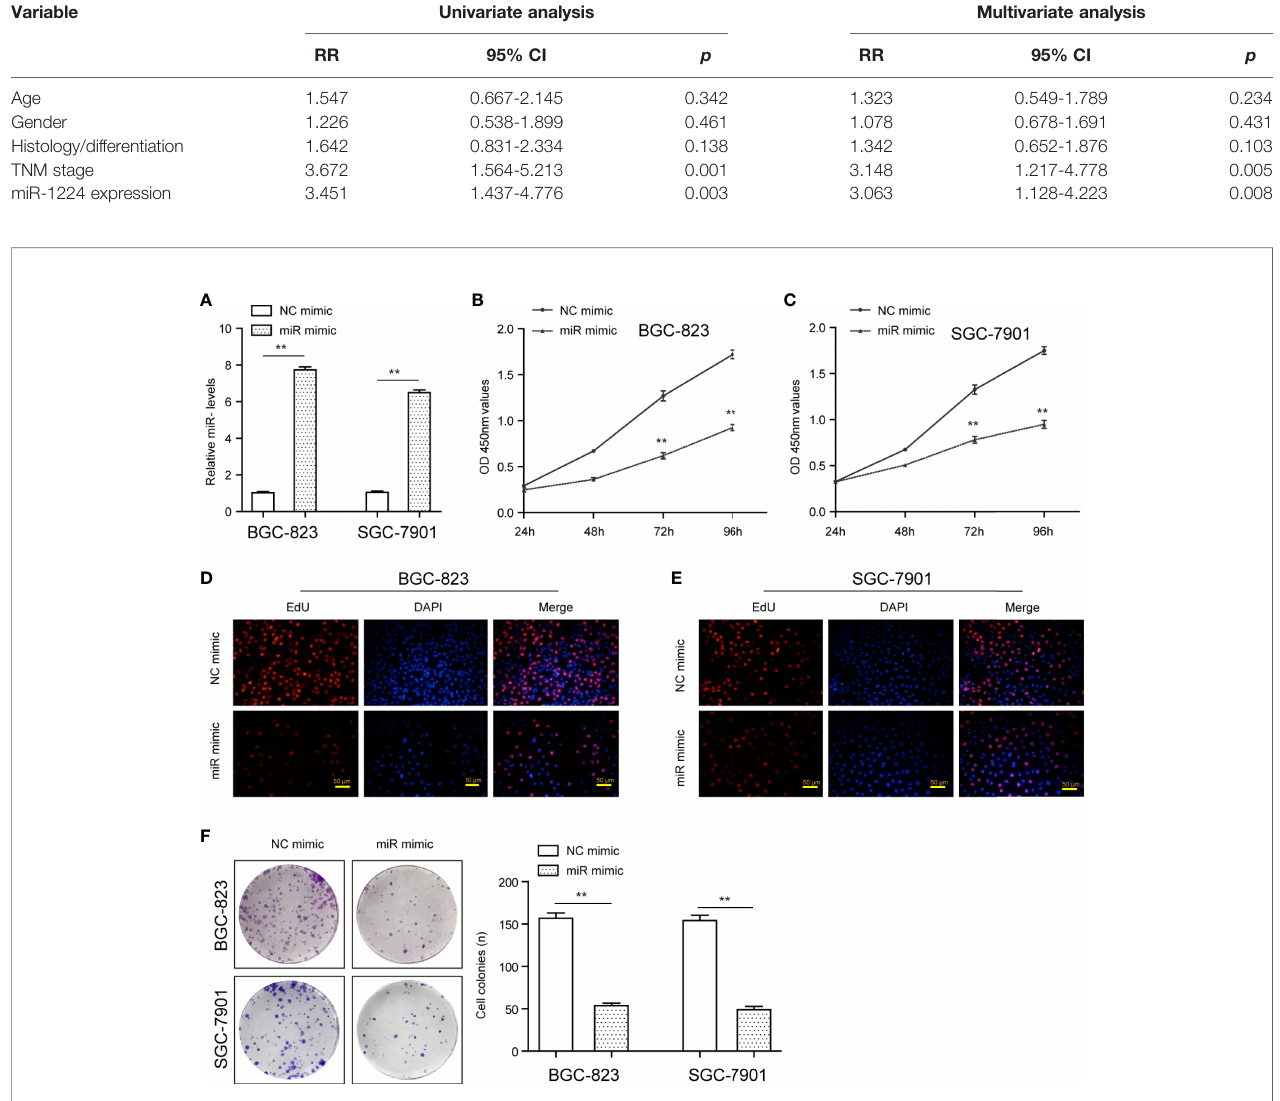
FIGURE 2 | MiR-1224 affected the proliferation of SGC-7901 and BGC-823 cells. (A) The qPCR assays determined the expression of miR-1224 in GC cells transfected with miR-1224 mimics. (B, C) The cellular growth of miR-1224 mimics-transfected GC cells was detected by CCK-8 assays. (D, E) EdU assays evaluated the cell proliferation of GC cells after treatment with miR-1224 mimics. The red color represented proliferative cells. The blue color indicated the nuclei stained by DAPI. (F) The colony formation abilities of GC cells were assessed using the colony formation assays. ** p < 0.01. Experiments were repeated three times with three